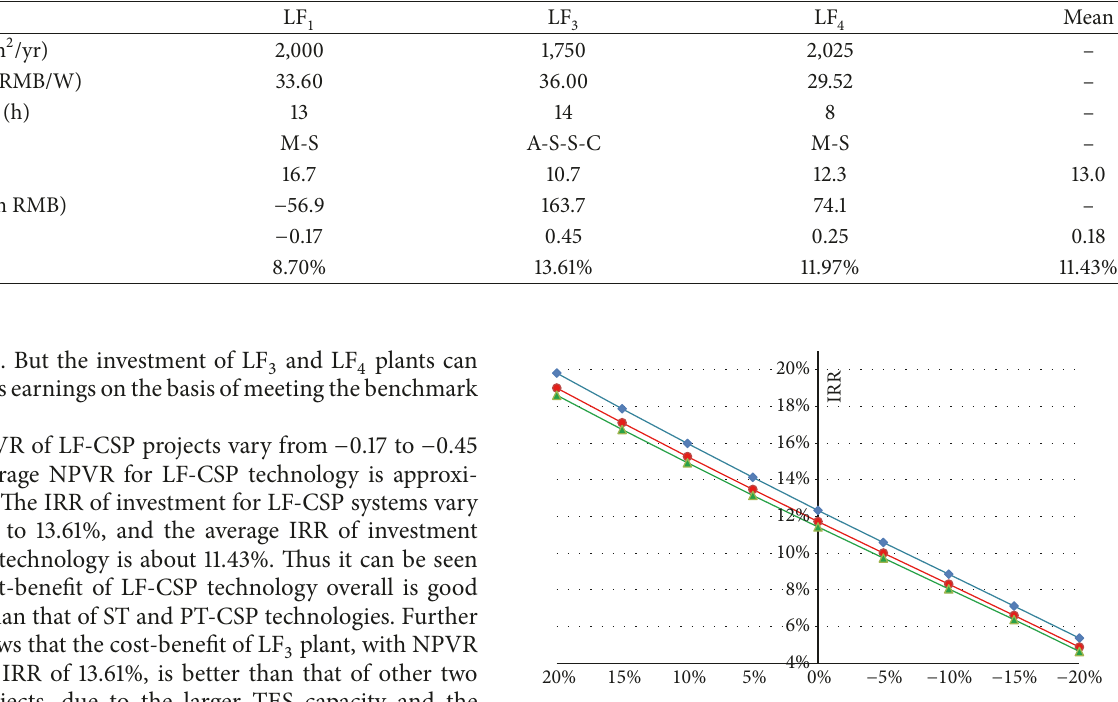
Table 5: Cost-benefit for the LF CSP of China.